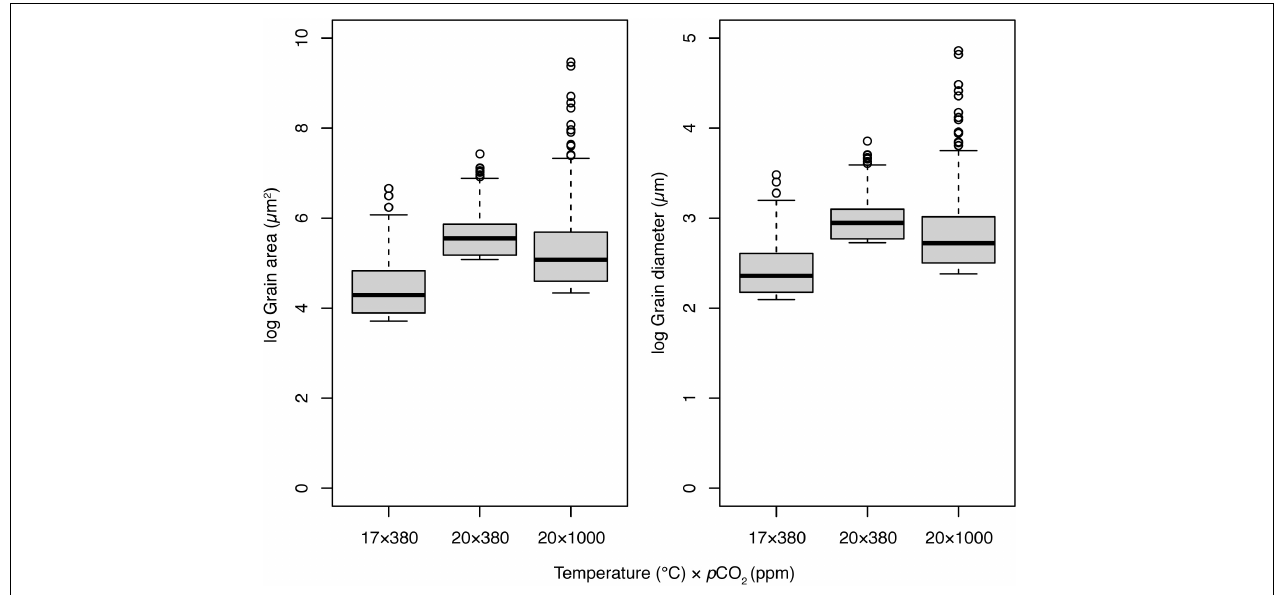
FIGURE 4 | Distribution of grain areas ( µ m 2 ) and diameters ( µ m) within regional subsets of Mytilus sp. exposed to three temperature ( ◦ C) and pCO 2 climate scenarios for 8-week. Thick lines of boxplots represent the median value, hinge lengths (end of box) represent the 25 and 75% quartiles from the median, and whiskers represent the 1.5 times the interquartile range (IQR) beyond the hinge. Outliers are shown as black